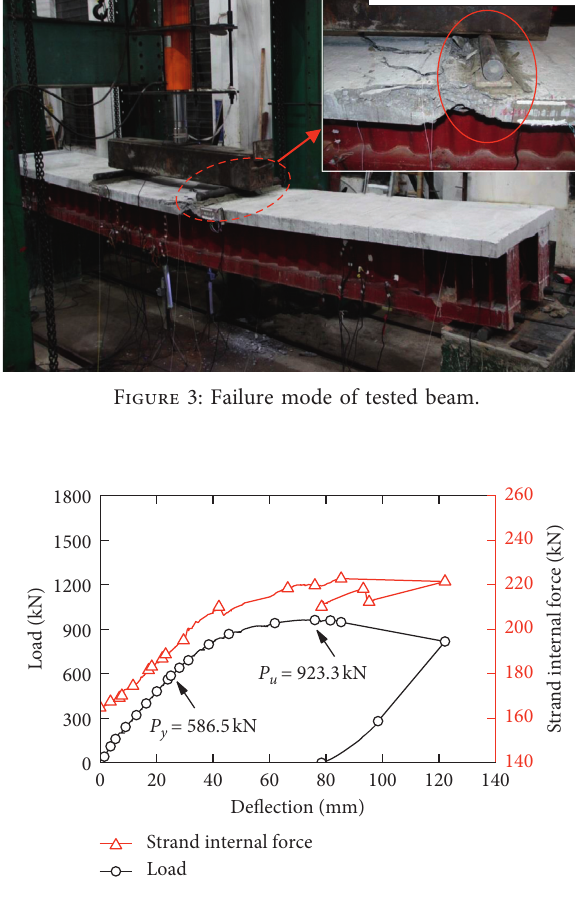
Figure 4: Experimental